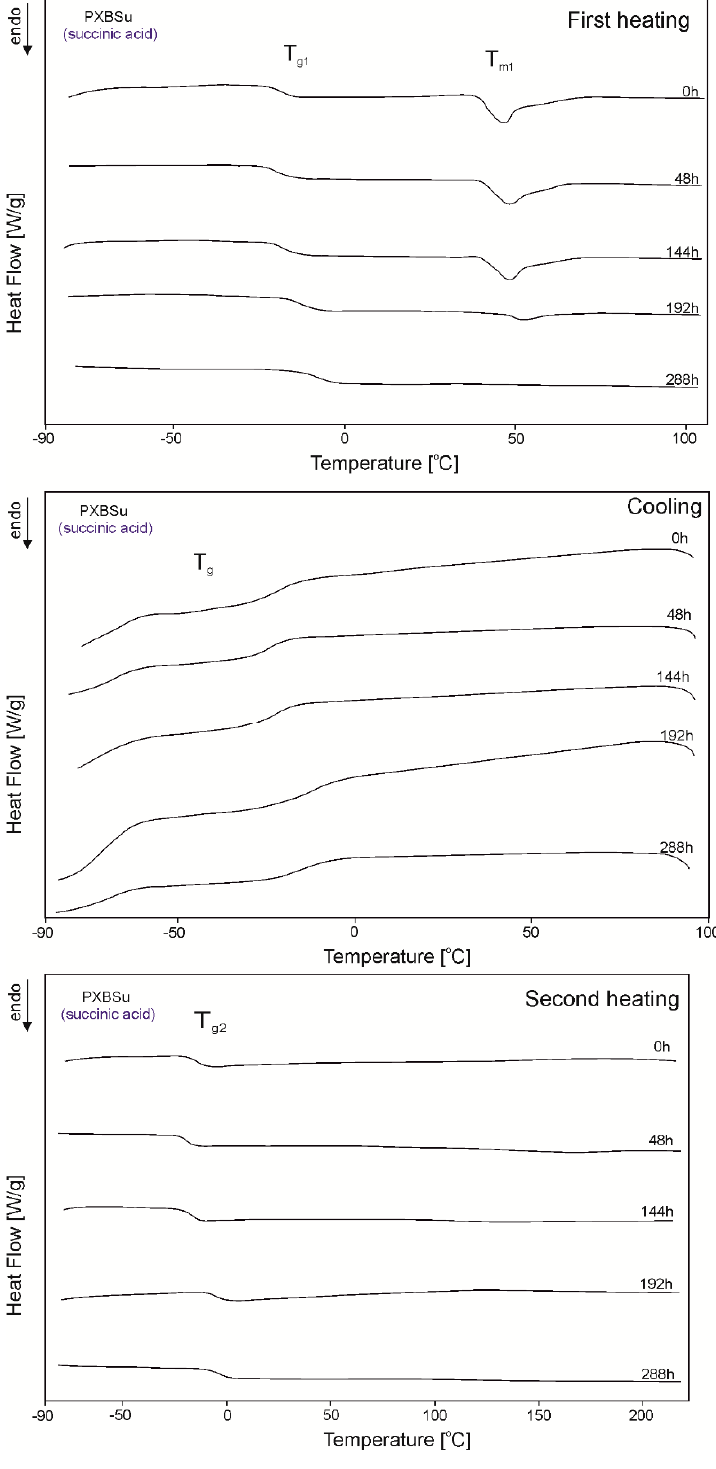
Figure 5. Di ff erential scanning calorimetry (DSC) thermograms of PXBSu at the crosslinking stages subjected to first heating, second heating and